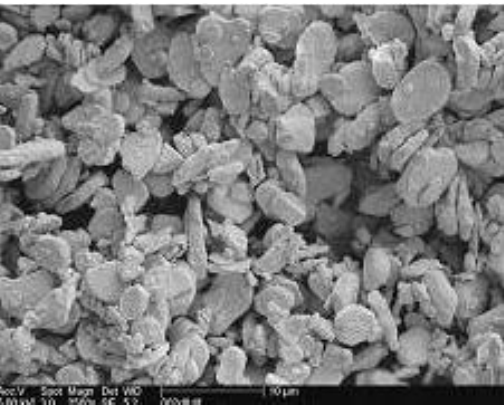
Figure 6. SEM image of BaFBr:Eu 2+ storage phosphor powder.